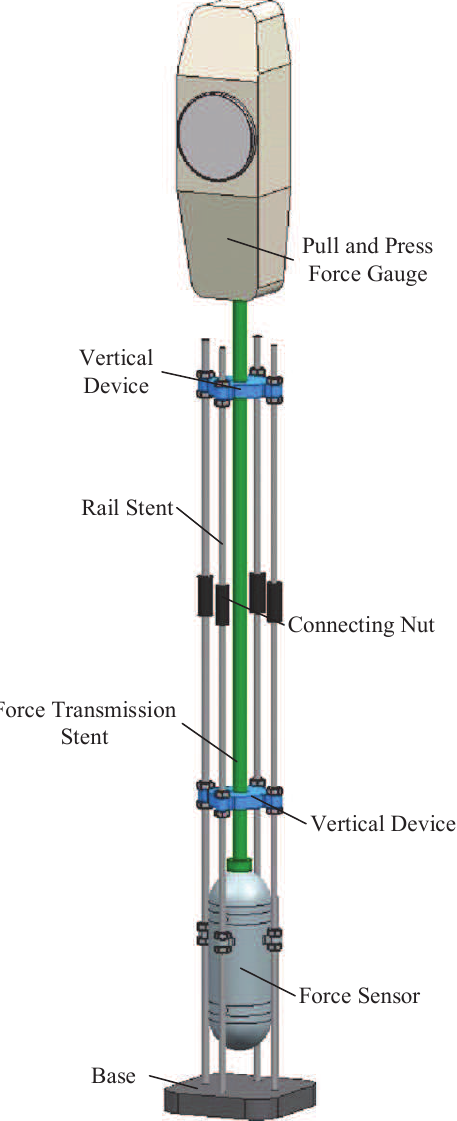
Figure 16. The schematic diagram of underwater standard force